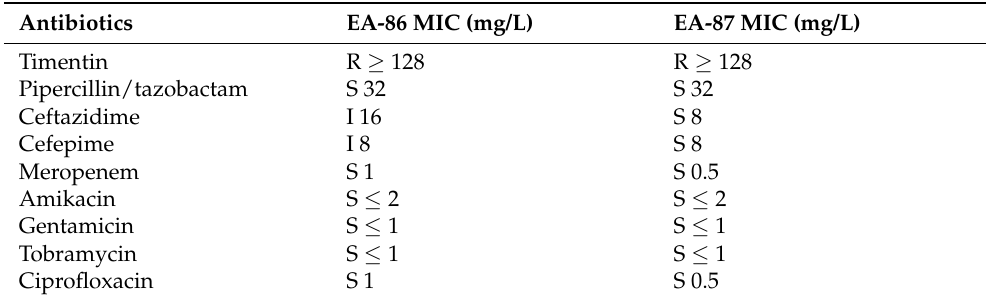
Table 1. Antimicrobial susceptibility of EA-86 and EA-87 blood culture isolates using VITEK 2 systems version 08.01 and AST-N246 card. (I—intermediate; R—resistant;